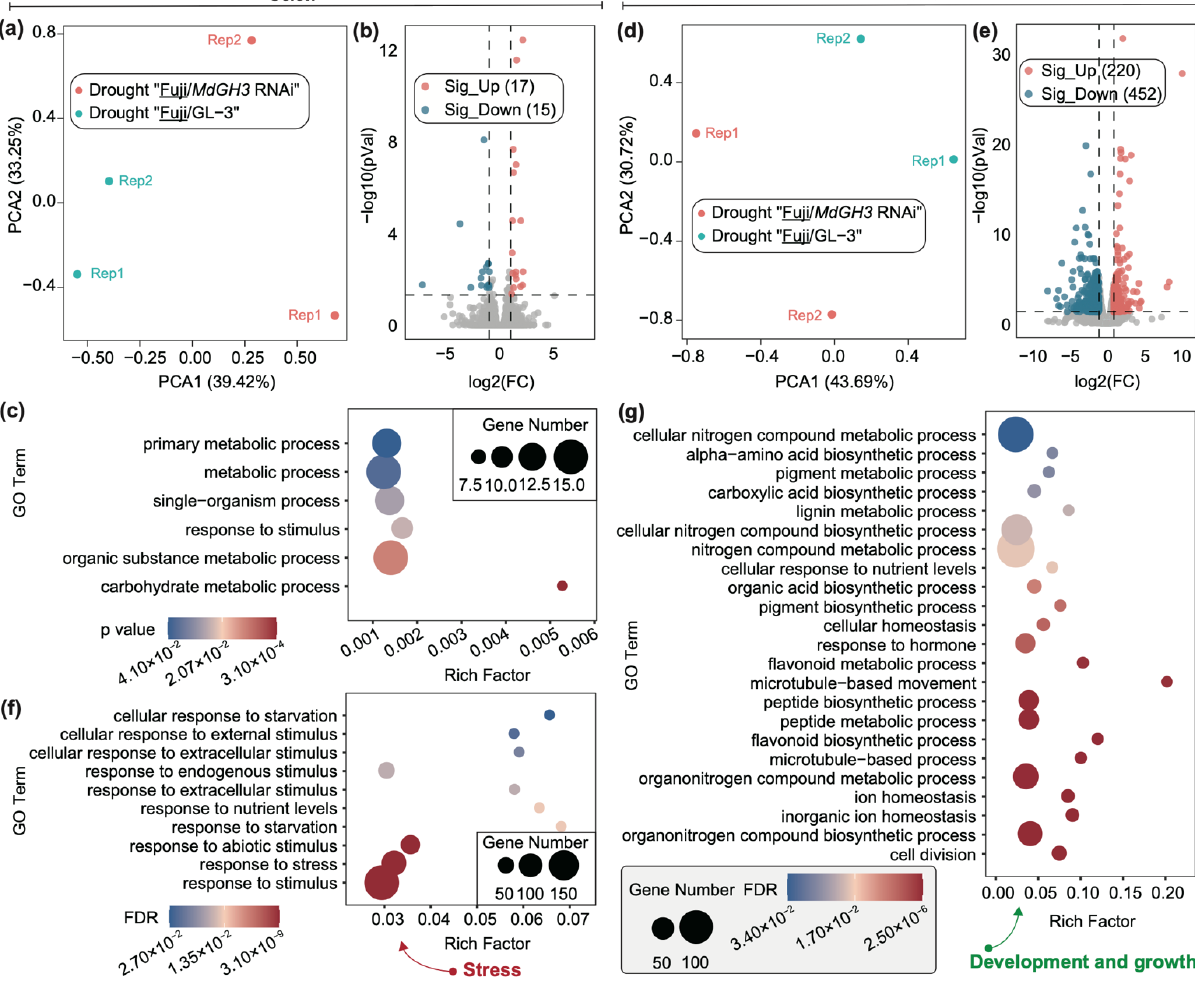
Figure 4. Differentially expressed genes (DEGs) in scion and rootstock obtained by comparing drought-treated “Fuji/ MdGH3 RNAi” plants with drought-treated “Fuji/GL-3” plants. ( a ) PCA plot showing the variation between scion (‘Fuji’) data of drought-treated “Fuji/ MdGH3 RNAi” and drought-treated “Fuji/GL-3”. ( b ) Volcano plot showing up- and down-regulated genes in scion of “Fuji/ MdGH3 RNAi” compared to “Fuji/GL-3” under drought conditions. ( c ) GO enrichment analysis of DEGs in scion. ( d ) PCA plot showing the variation between drought-treated rootstock ( MdGH3 RNAi and GL-3) data of “Fuji/ MdGH3 RNAi” and “Fuji/GL-3”. ( e ) Volcano plot showing up- and down-regulated genes in drought-treated MdGH3 RNAi plants compared to drought-treated GL-3. ( f , g ) GO enrichment analysis of DEGs in rootstock. The GO terms were divided into “development and growth” and “stress”